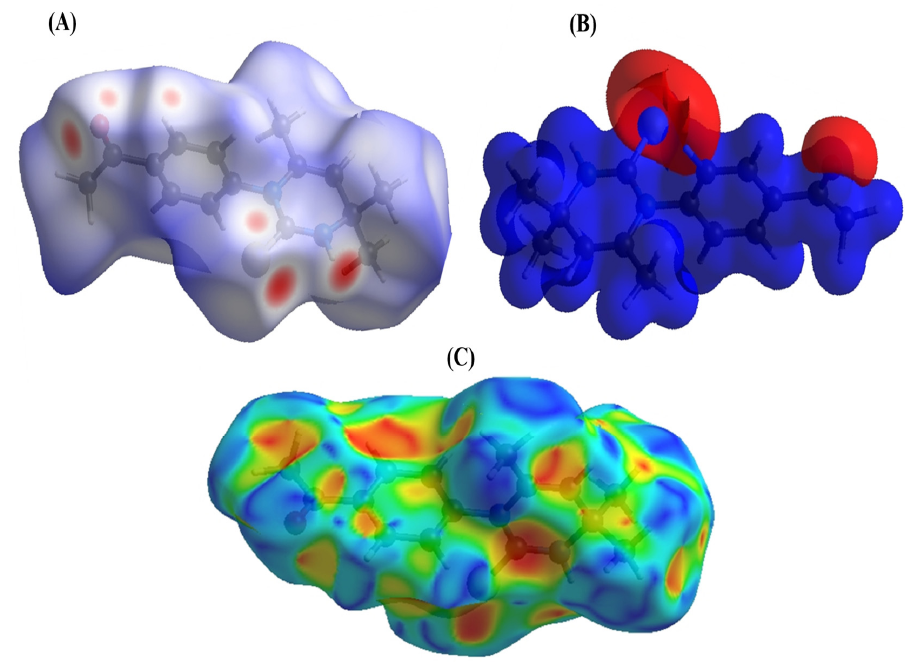
Figure 4. ( A ) View of 3D diagram of compound 4 plotted over d norm ( B ) 3D diagram of compound 4 plotted over electrostatic potential energy ( C ) 3D diagram of compound 4 plotted over shape- index